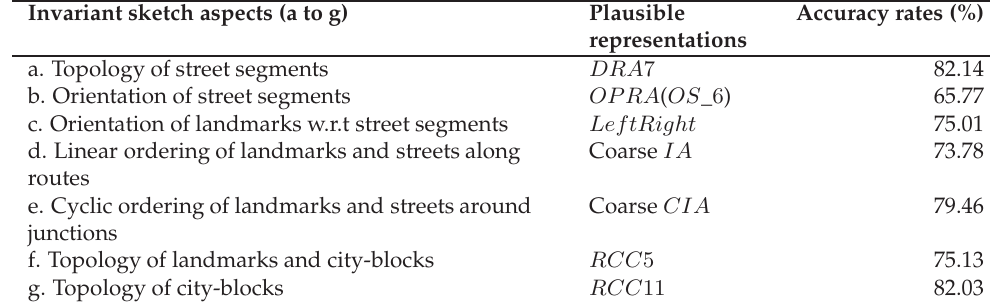
Table 1: The sketch aspects and plausible representations with the accuracy rates of matches. The accuracy rates are compiled results of correctly matched street segments, landmarks, and